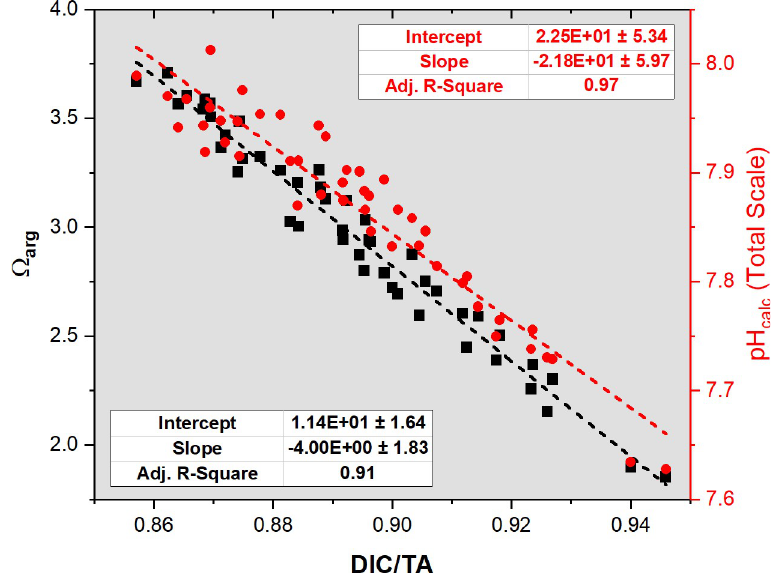
Fig 5. Linear correlation of the DIC/TA ratio with pH and Ω arg